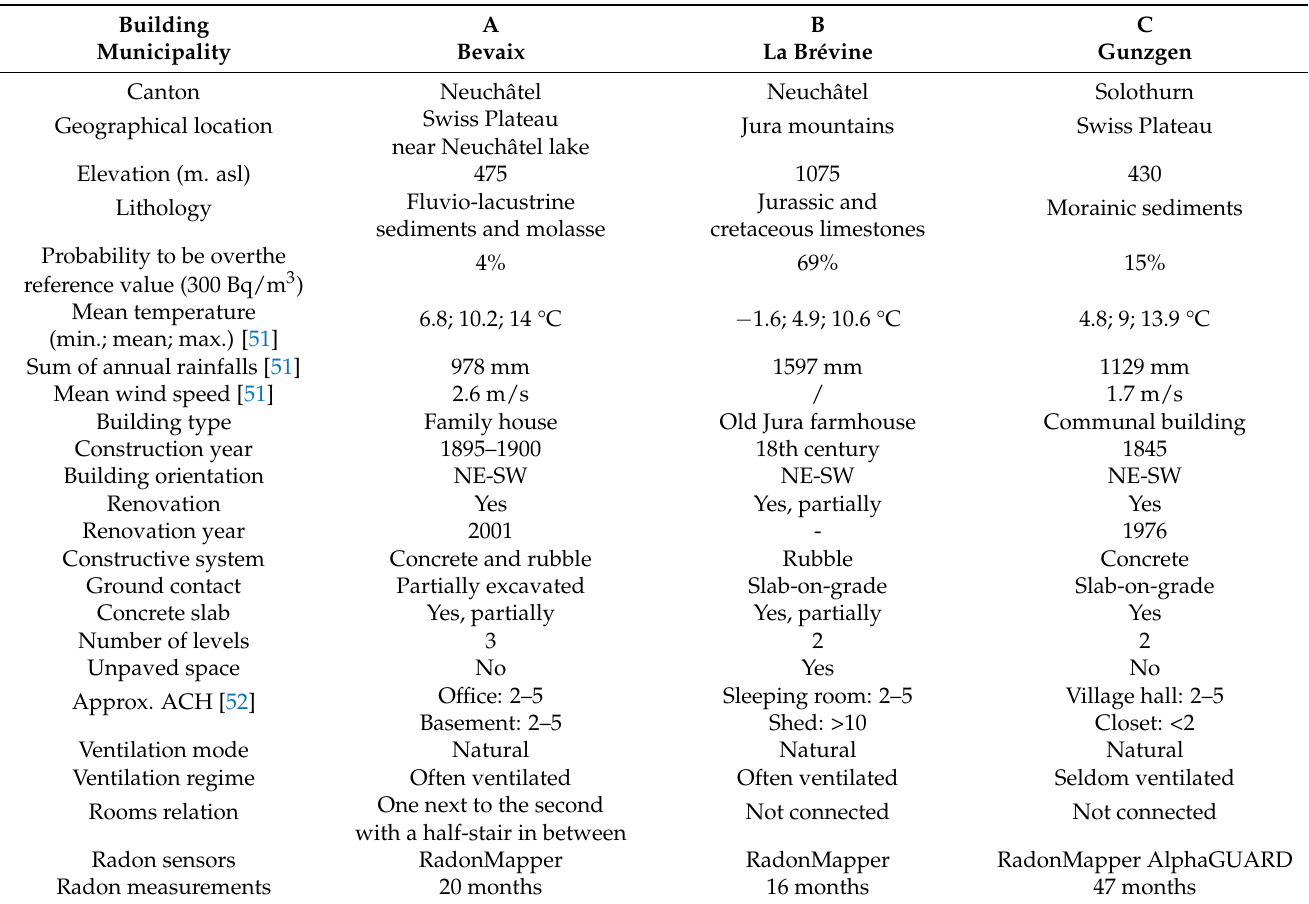
Figure A2. Timeline of the radon measurement acquisition. Dataset are standardized according to deep green periods. Table A1. Studied buildings’ geographical, geological, meteorological, built and radon characteristics.